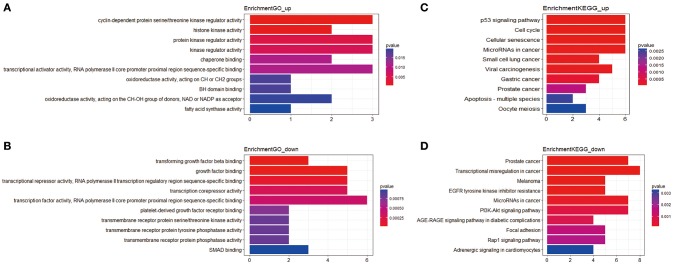
The functional enrichment analysis of mRNAs in the ceRNA network. (A) Gene Ontology enrichment analysis of upregulated mRNAs. (B) Gene Ontology enrichment analysis of downregulated mRNAs. (C) KEGG pathway analysis of upregulated mRNAs. (D) KEGG pathway analysis of downregulated mRNAs. The horizontal axis represents gene counts. The vertical axis represents enrichment analysis terms.